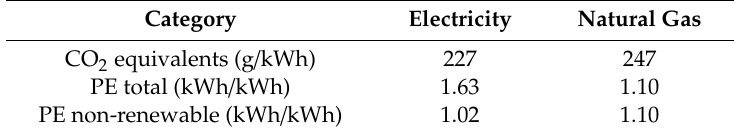
Table 4. CO 2 emissions and primary energy factors for electricity and natural gas according to Ref.